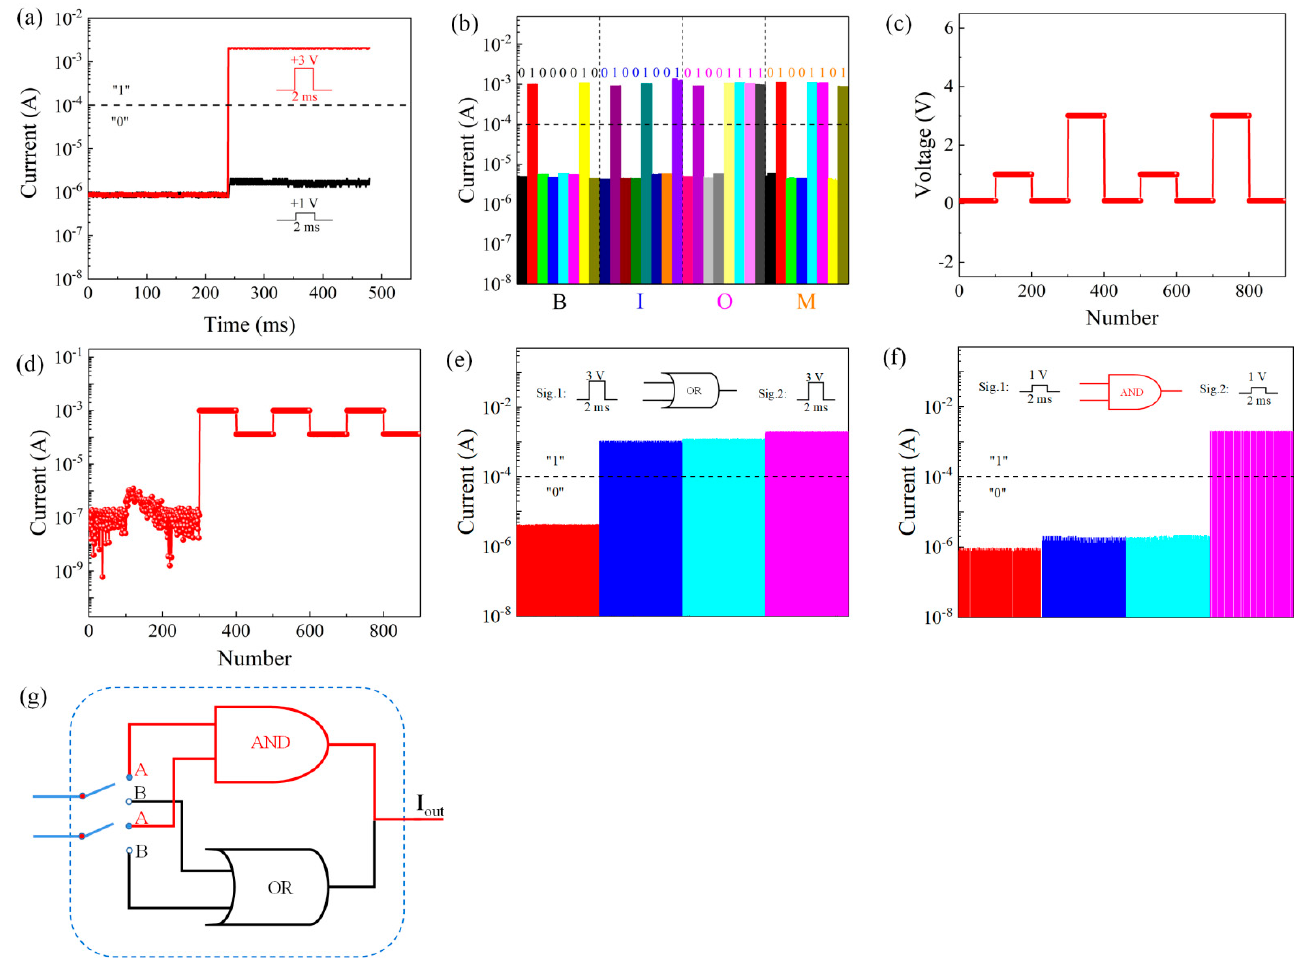
Figure 4. ( a ) Two input signals. ( b ) logic display of the word “BIOM”. Current response of the device under continuous pulse application: ( c ) voltage input and ( d ) current response. ( e ) “OR” gate. ( f ) “AND” gate. ( g ) working principle of the logic cell. Table 1 . OR gate.